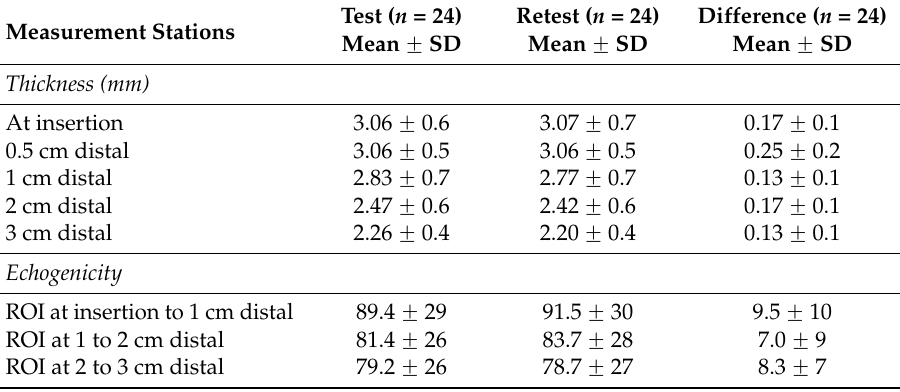
Table 1. Showing means and standard deviations of both the test and retest for measurement of plantar thickness and echogenicity and the differences between measurements (ROI = region of interest) using the mean of three measurements from three